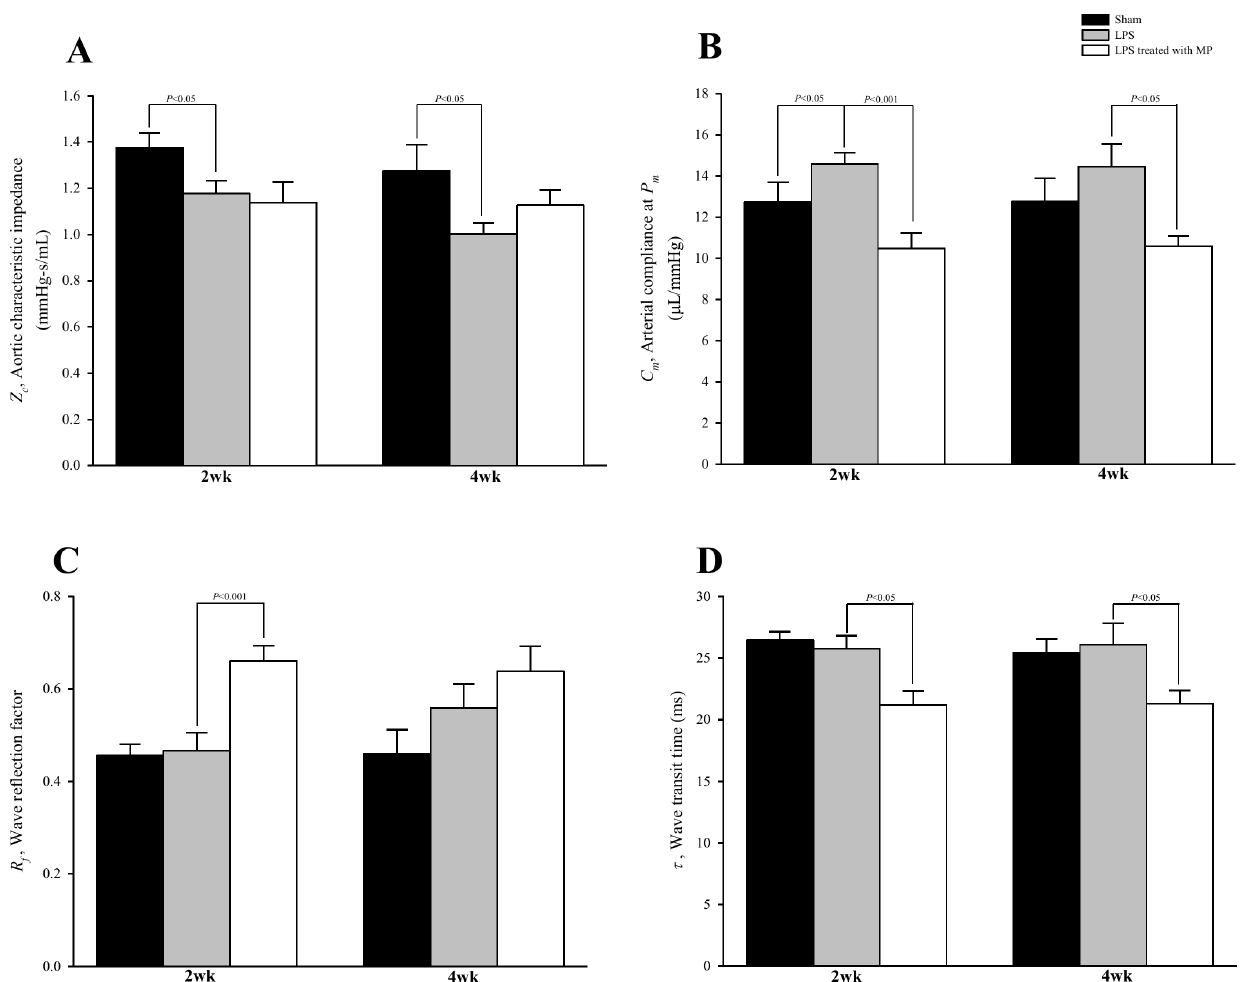
Figure 6. Effects of LPS and MP on aortic characteristic impedance ( Z c in A), systemic arterial compliance at mean aortic pressure ( C m in B), wave reflection factor ( R f in C) and wave transit time ( t in D). Data are expressed as mean 6 s.e. LPS, lipopolysaccharide; MP, methylprednisolone. ( n =10 in each